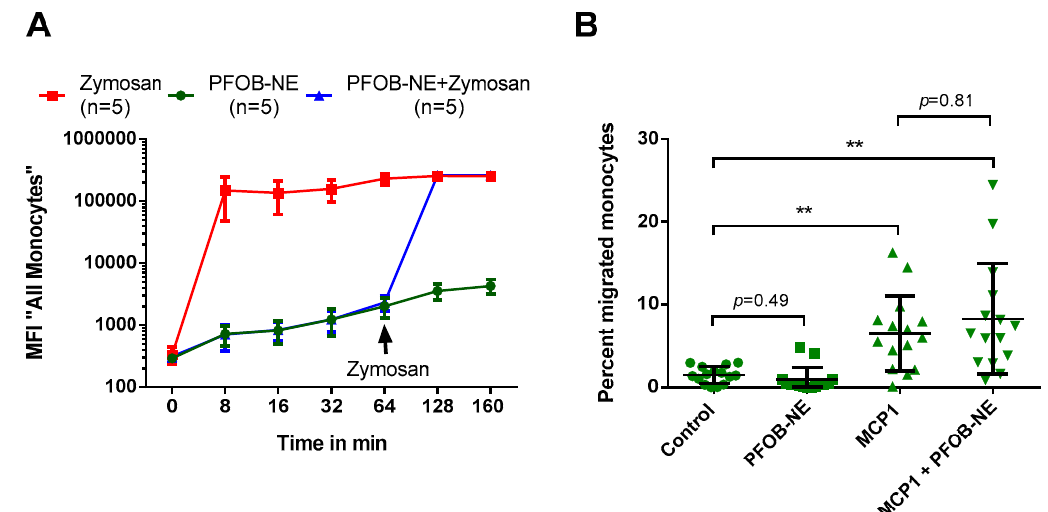
Figure 6. Monocytes remain functional after PFOB-NE ingestion. ( A ) Whole blood samples were either exposed to 6-FAM-labeled PFOB-NE or FITC-labeled Zymosan, a reference marker for phagocytosis. In a third group Zymosan was added 64 min after PFOB-NE exposure. Fluorescence uptake was monitored by flow cytometry. No difference in the amount of ingested Zymosan was observed between monocytes pre-stimulated or not pre-stimulated with PFOB-NE. ( B ) Monocyte migration was evaluated using a transwell migration assay with a pore size of 3 µm. Migration was stimulated by MCP1 (10 ng/mL). The percentage of migrated monocytes was evaluated using flow cytometry. Pre-stimulation with PFOB-NE for 160 min did not have an impact on the percentage of migrated monocytes. n = 15, ** p < 0.01.